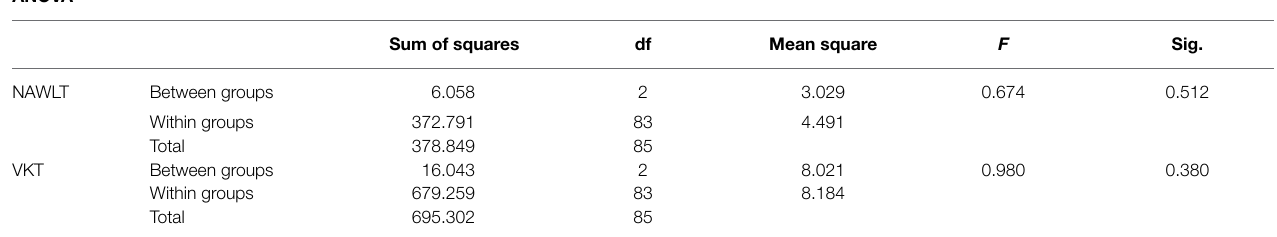
TABLE 3 | One-way between-groups ANOVA for the scores on pre-test. ANOVA Sum of squares df Mean square F Sig.